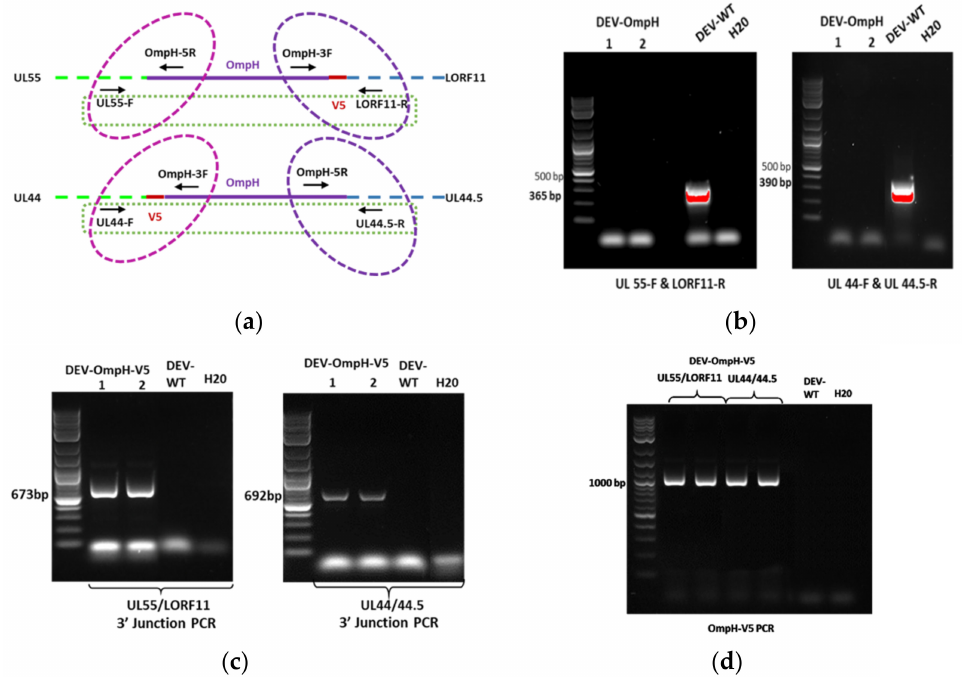
Figure 4. Verification of the recombinant DEV-OmpH-V5 by PCR. ( a ) The name and position of primers use for verification purification (Square shape) and 5 (cid:48) and 3 (cid:48) junction PCR (Oval shape). ( b ) The purification of DEV-GFP-OmpH-V5 recombinant virus in each insertion site and DEV wild type were detected by PCR. The primers pair between each intergenic region of DEV genome labelled under the panel. ( c ) 3 (cid:48) junction PCR verification of DEV-GFP-OmpH-V5 with specific primers in each site to confirm integration and identification insertion sites. Sense orientation insertion of DEV- GFP-OmpH-V5 of UL55-LORF11 was detected by primer pair OmpH-3F & LORF11-R and anti-sense direction of UL44-44.5 was detected by primer pair OmpH-3F and UL44-R. ( d ) The confirmation of whole OmpH-V5 gene inserted in each recombinant DEV comparing with DEV wild type was identified by PCR using primers OmpH-F and OmpH-V5-R. The molecular size of DNA is indicated in the left